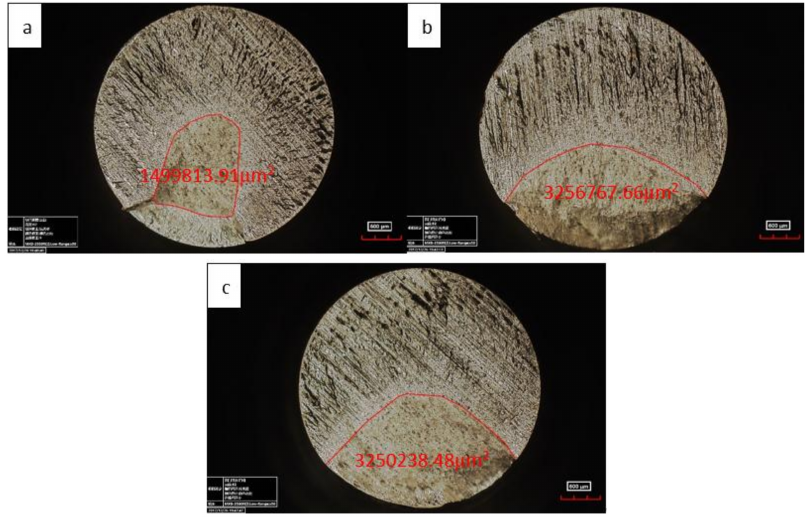
Figure 9. Fatigue fracture surfaces of 7075-T7351 Al alloy under the same stress amplitude 113.3 MPa. ( a ) N f = 3.52 × 10 4 ; ( b ) N f = 4.210 × 10 5 ; ( c ) N f = 8.126 × 10 5